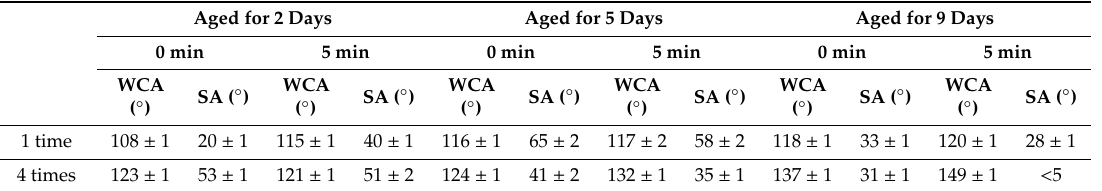
Table 1. Values of water contact angle (WCA) and sliding angle (SA) obtained for samples as a function of the duration of the dipping and the number of coatings.